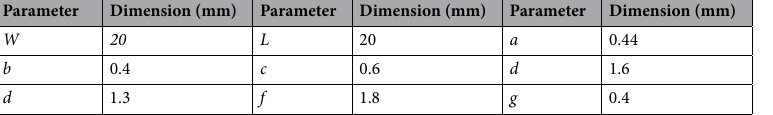
Table 1. Dimension of the various segments of the MTM.